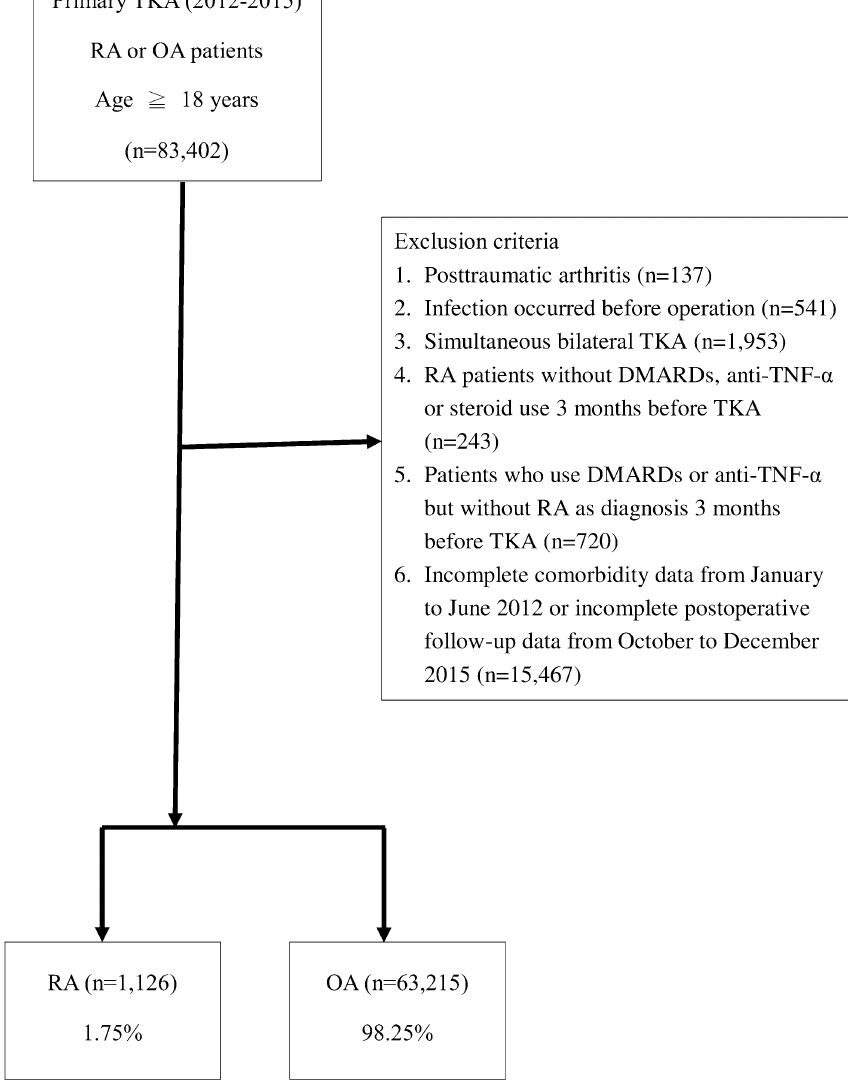
Figure 1. Flow chart of patient inclusion. DMARDs, disease-modifying antirheumatic drugs; OA, osteoarthritis; RA, rheumatoid arthritis; TKA, total knee arthroplasty; TNF, tumor necrosis